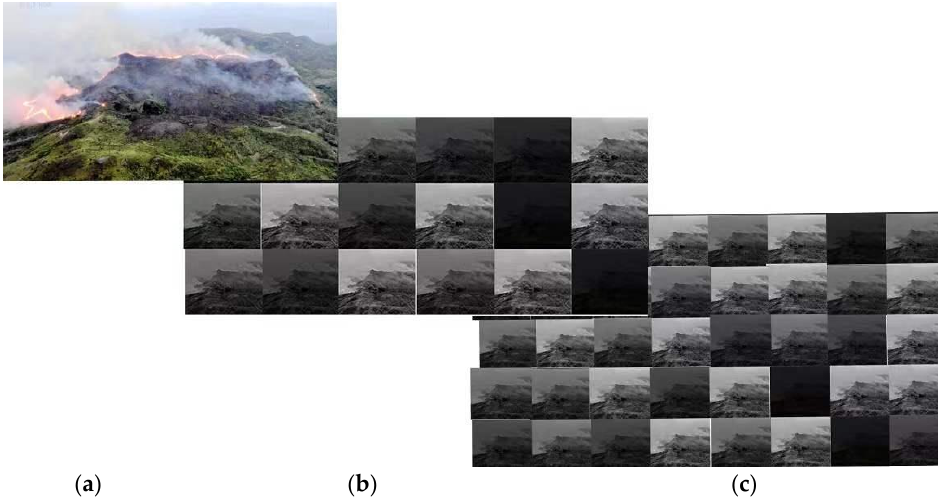
Figure 7. The feature mapping process after the Conv 2 and Conv 3 layers in the DCN_Fire model. ( a ) The original input image, ( b ) the Conv 2 feature map, and ( c ) the Conv 3 feature map.